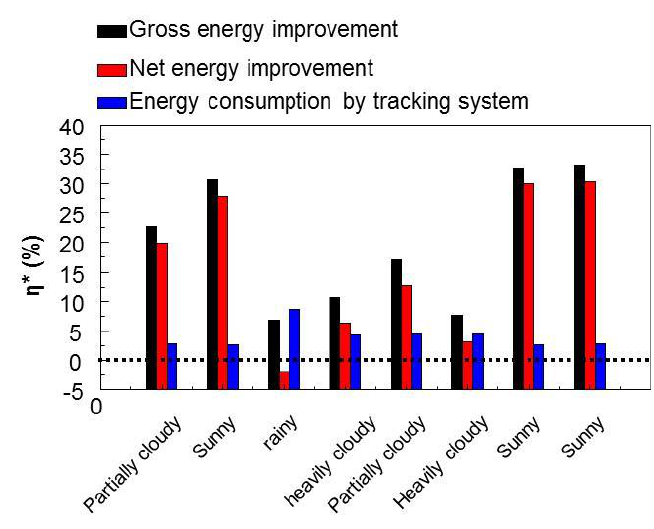
Figure 9. Energy improvement of the sun tracker under different weather conditions.